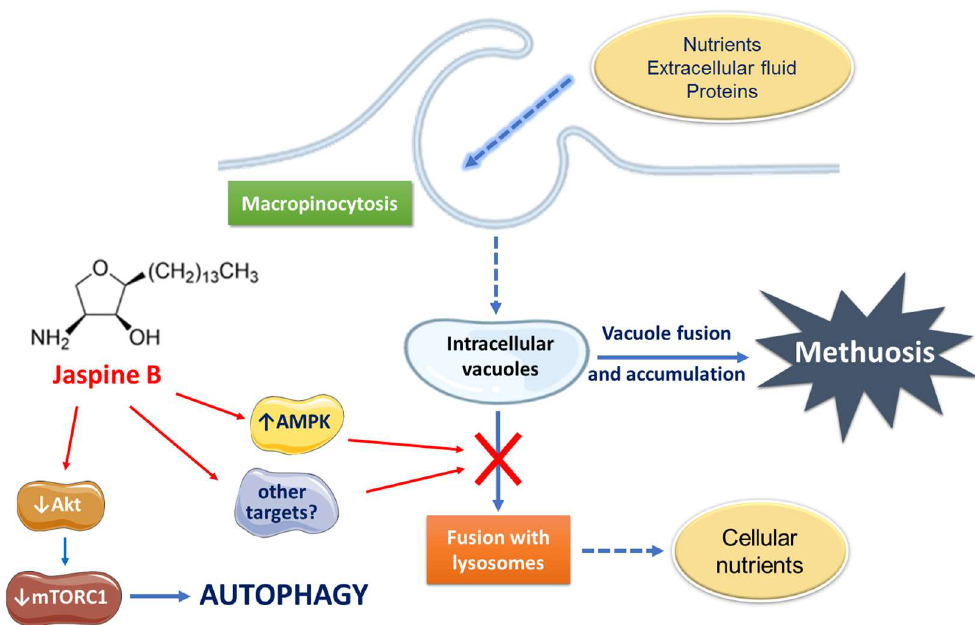
Figure 7. Proposed mode of action of Jaspine B in lung adenocarcinoma A549 and gastric cancer HGC-27 cells.